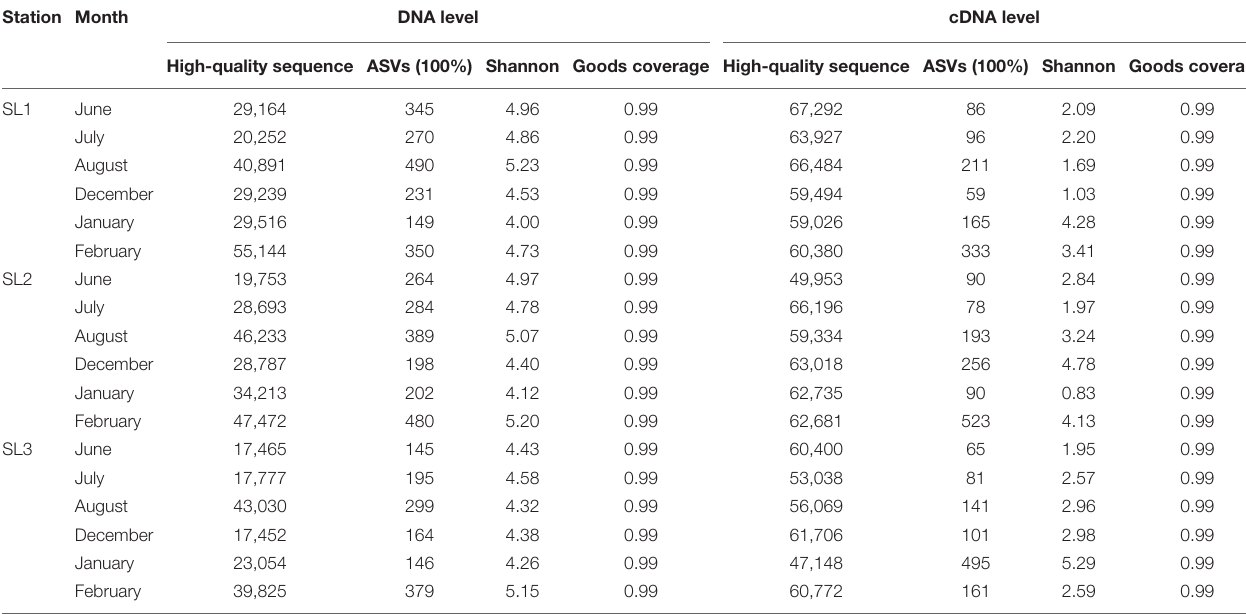
TABLE 1 | Results of rpo C1 amplicon sequencing at DNA and cDNA levels. Station Month DNA level cDNA